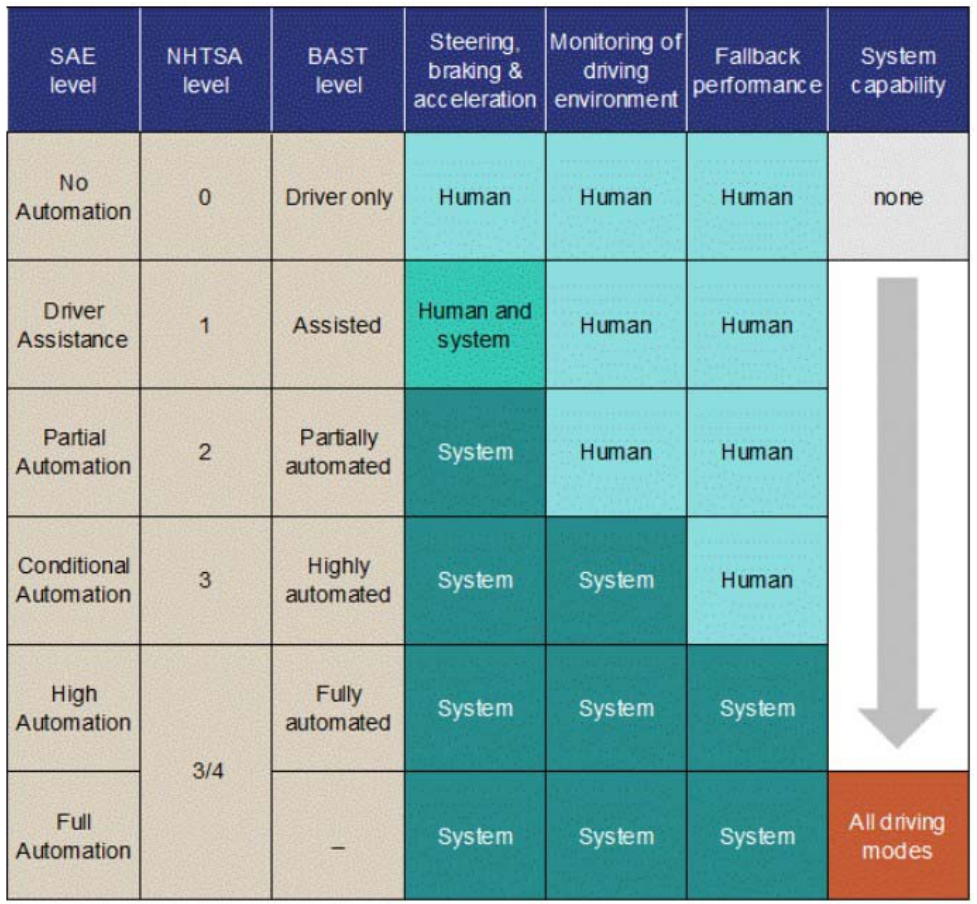
Figure 8. Vehicle driving automation milestones adopted by ASE, NHTSA, and BAST. Source: https://www.schlegelundpartner.com (/cn/news/man-and-machine-automated-driving).